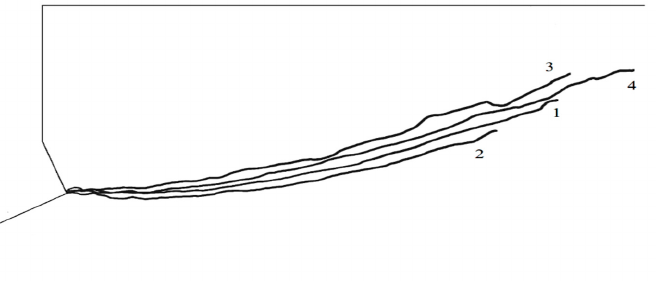
Figure 8. Summary of the determined damage trajectories: No. 1—E II = 9287 MPa, ν 3 = 0.25; No. 2—E II = 9287 MPa, ν 4 = 0.30; No. 3—E I = 14,276 MPa, ν 1 = 0.15, No. 4—E I = 14,276 MPa, ν 1 = 0.20.